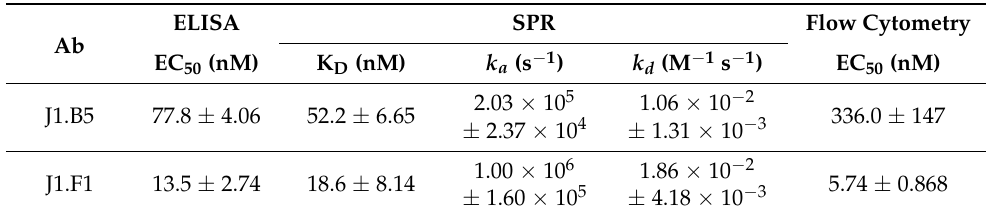
Table 1. Binding properties of anti-JAG1 B5 and F1 Abs to JAG1. EC 50 values for rhJAG1 and endoge- nous cellular JAG1 from HepG2 cells were determined by ELISA and flow cytometry, respectively. Affinity constants were estimated with SPR assays with JAG1-ECD-Fc protein. Data are mean values ± SD ( n = 3). Ab